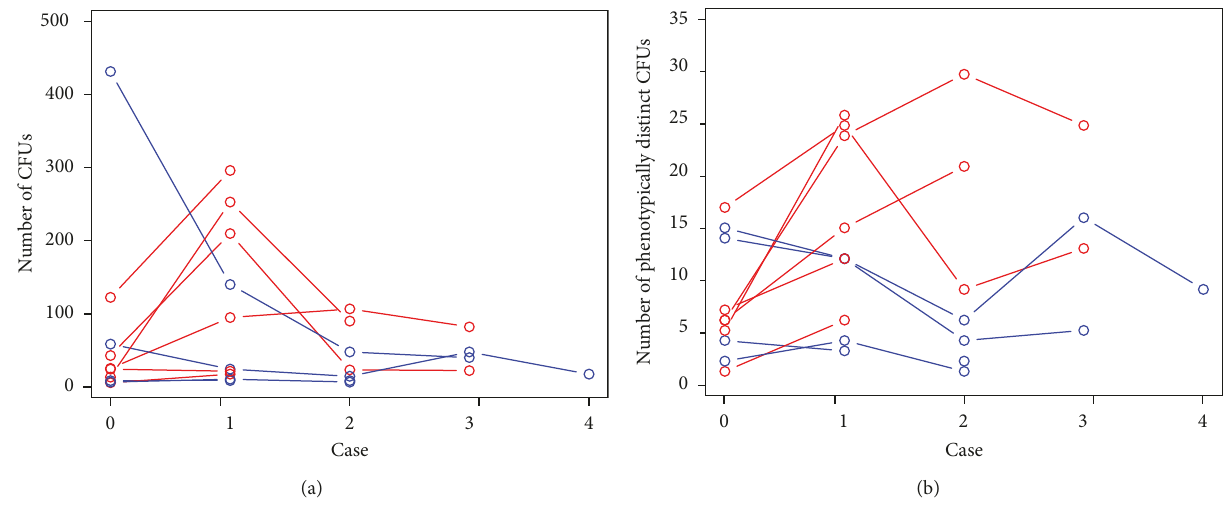
Figure 3: The global density and diversity of CFUs across time. (a) Density of CFUs. (b) Diversity of CFUs. (a) presents a schematic depiction of the density (quantity), and (b) presents a depiction of the diversity (phenotypically distinct) of CFUs across time. Each line represents cases in a particular OR. The blue lines depict cases in which the anesthesia machine was covered with the AMW, and the red lines depict cases where an AMW was not employed. In cases where the AMW was used, there was a decrease or plateauing of the density of CFUs, while in those cases without the AMW there was general increase in the density of CFUs. Relatedly, in cases without the AMW, additional, phenotypically distinct species were added to the anesthesia machine, suggesting ongoing contamination with the anesthesia provider as vector. Note that in cases where theAMW was used, there tended to be a reduction or stabilization in bacterial species, with one exception, which suggests contamination possibly during the cleaning or machine preparation. CFUs colony forming units; AMW anesthesia machine wrap. (cid:31) (cid:31)